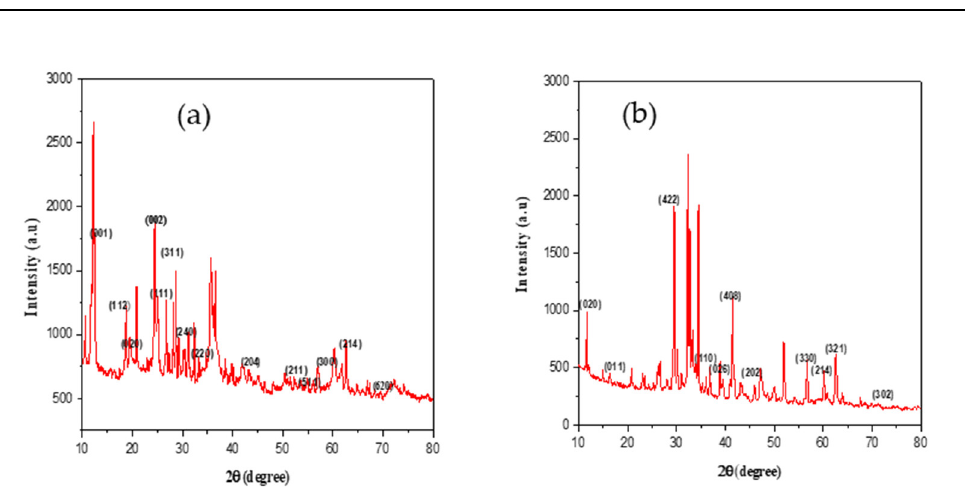
Figure 2. XRD patterns of tailings ( a ) and ordinary Portland cement ( b ). Table 1. Physical characteristics of tailings and ordinary Portland cement.